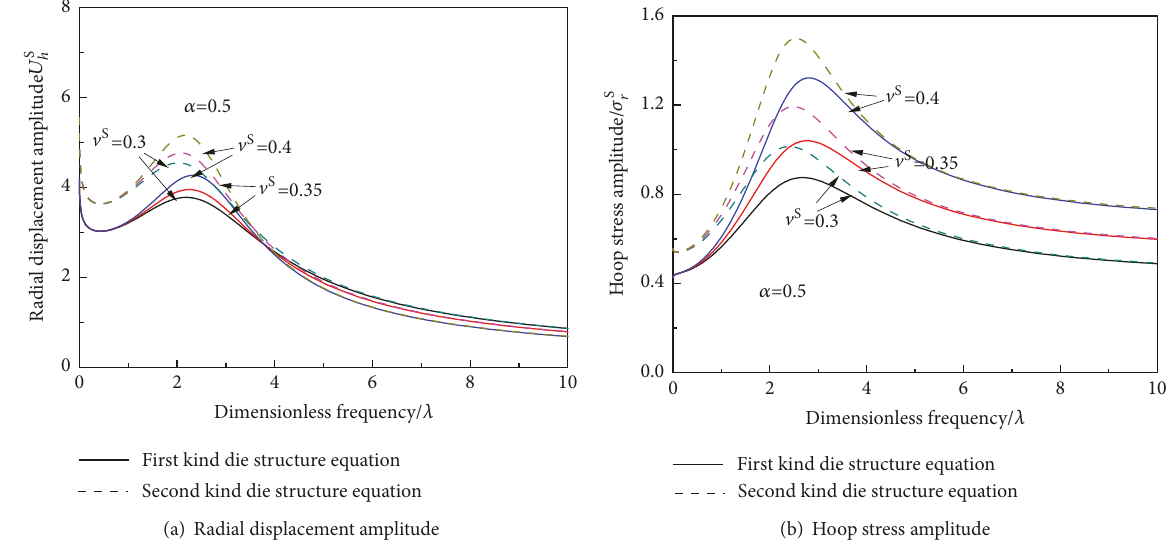
Figure 5: Influence of Poisson’s ratio on radial displacement and hoop stress amplitude.